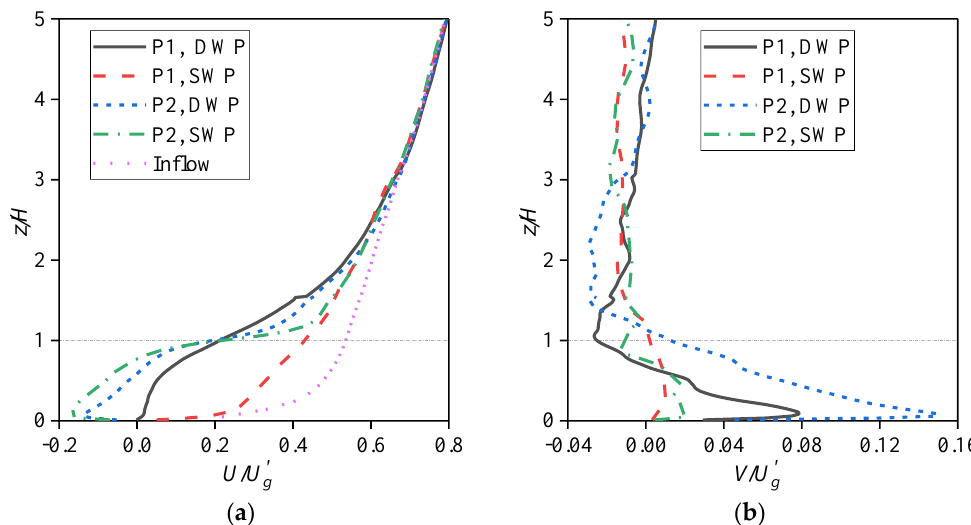
Figure 15. ( a )The U and ( b ) V profiles at P1 (the wake region behind the building model B 4,2 centerline) and P2 (wind passage region between building models B 4,2 and B 4,3 ).